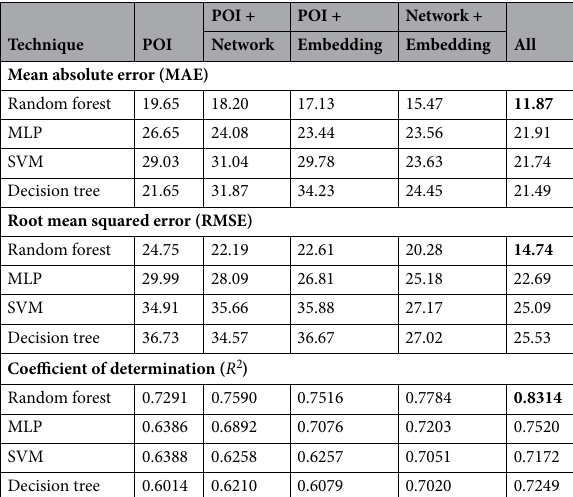
Figure 3 and Table 3 highlight some of the techniques and feature combinations used to generate ALF-Score for the city of Montréal using the user opinion data collected from the same city. Random forest, using all features produces the best results with the least MAE. As we explored in the background section, the goal of transfer learning is to take advantage of previously trained models, for instance models trained on the city of St. John’s NL in our previous works, to essentially extract knowledge that could be useful when applied to training new models (Combined approach) for new cities. However, transfer learning is also very useful to directly generate predictions for new cities without any more learning (Zero-user-input approach). Zero-user-input was our first transfer learning approach. Tables 4 and 5 and Fig. 4 highlight various experimentation performed on these 3 approaches over different feature combinations